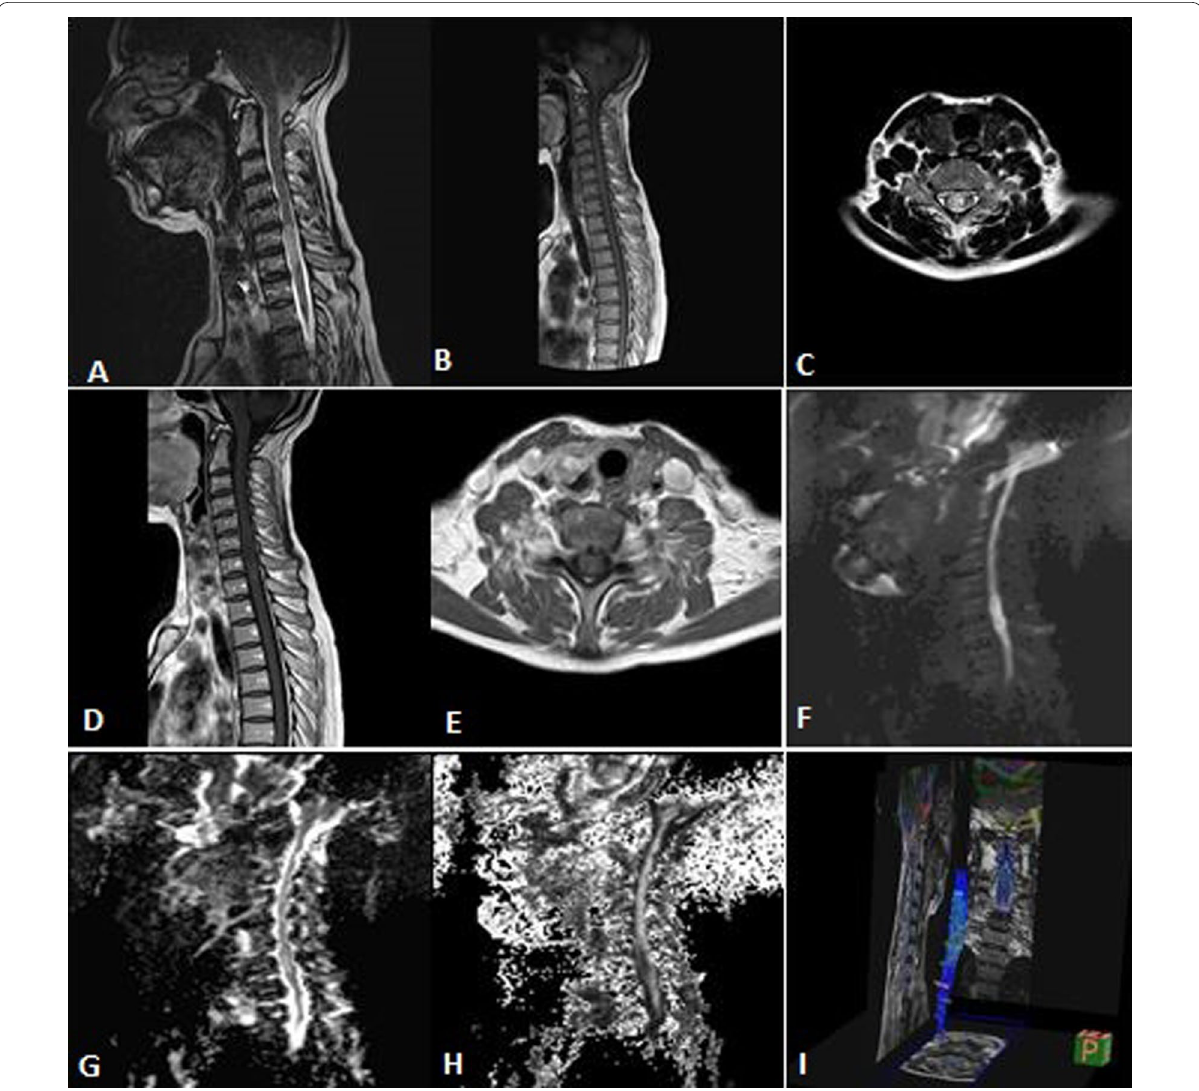
Fig. 3 A 45‑years old female patient presented with progressive quadriparesis of 30 days duration. Sagittal T2‑weighted ( A ) and sagittal T1‑weighted ( B ), axial T2‑weighted ( C ), sagittal and axial T1‑weighted imges postcontrast ( D & E ) images show ill‑defined patchy high T2 signal intensity of the spinal cord opposite at C5 & C6 vertebral body levels. Postcontrast study show irregular patchy peripheral enhancement at the lesion…Diagnosis: Transverse myelitis. Sagittal Trace ( F ), ADC ( G ), gray scale FA ( H ) & 3D MR tractography ( I ) image show high trace signal with bright ADC and low FA central signal intensity. The tractogram shows expansion of the spinal cord with mixed color